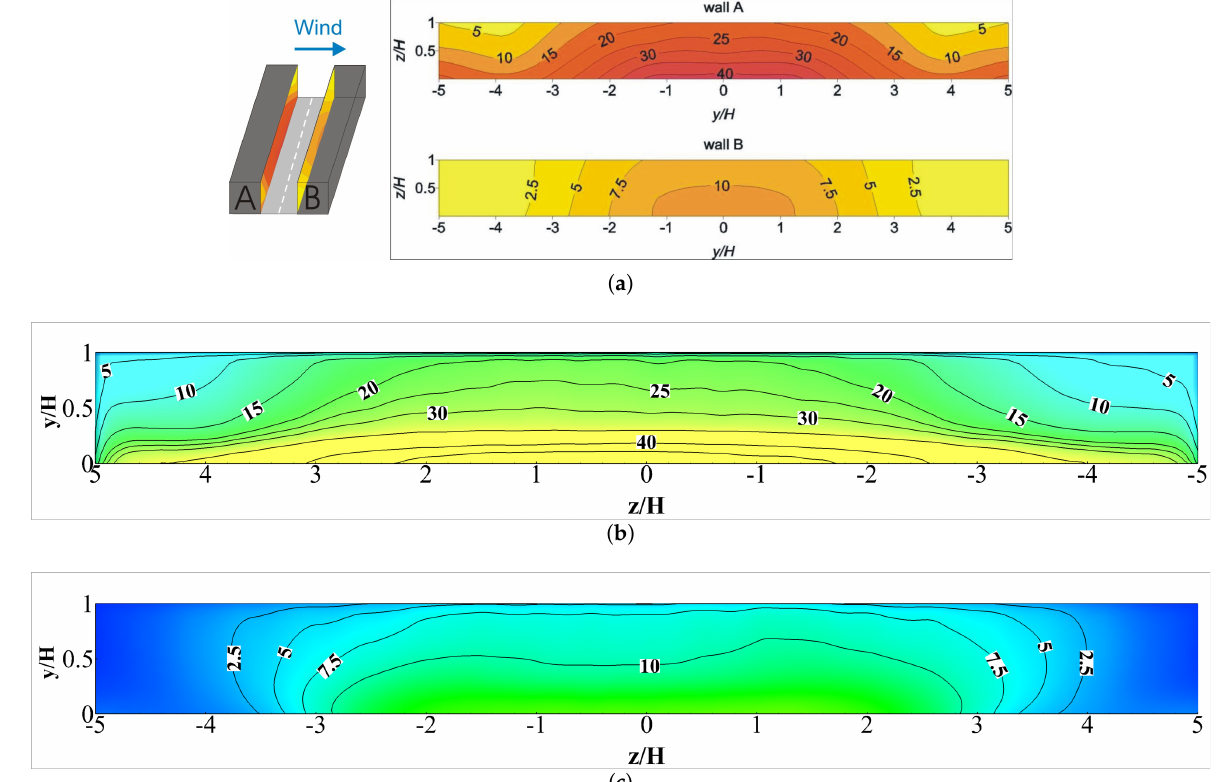
+ (cid:105) Figure 4. Time-averaged normalized pollutant concentration (cid:104) C data on wall A (leeward) and wall B (windward) presenting comparison of current LES vs. WT Experiment. ( a ) Wind tunnel experi- ment data [17–20] ©CODASC, KIT, https://www.umweltaerodynamik.de/bilder-originale/CODA/ CODASC.html (accessed on 20 June 2022); ( b ) wall A for present LES; ( c ) wall B for present LES.